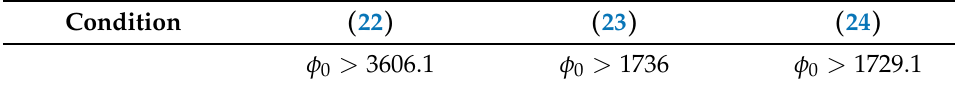
Table 1. Conditions (22), (23) and (24) when ϕ 0 = 16, µ = 1/2, and λ = 1/6. Condition